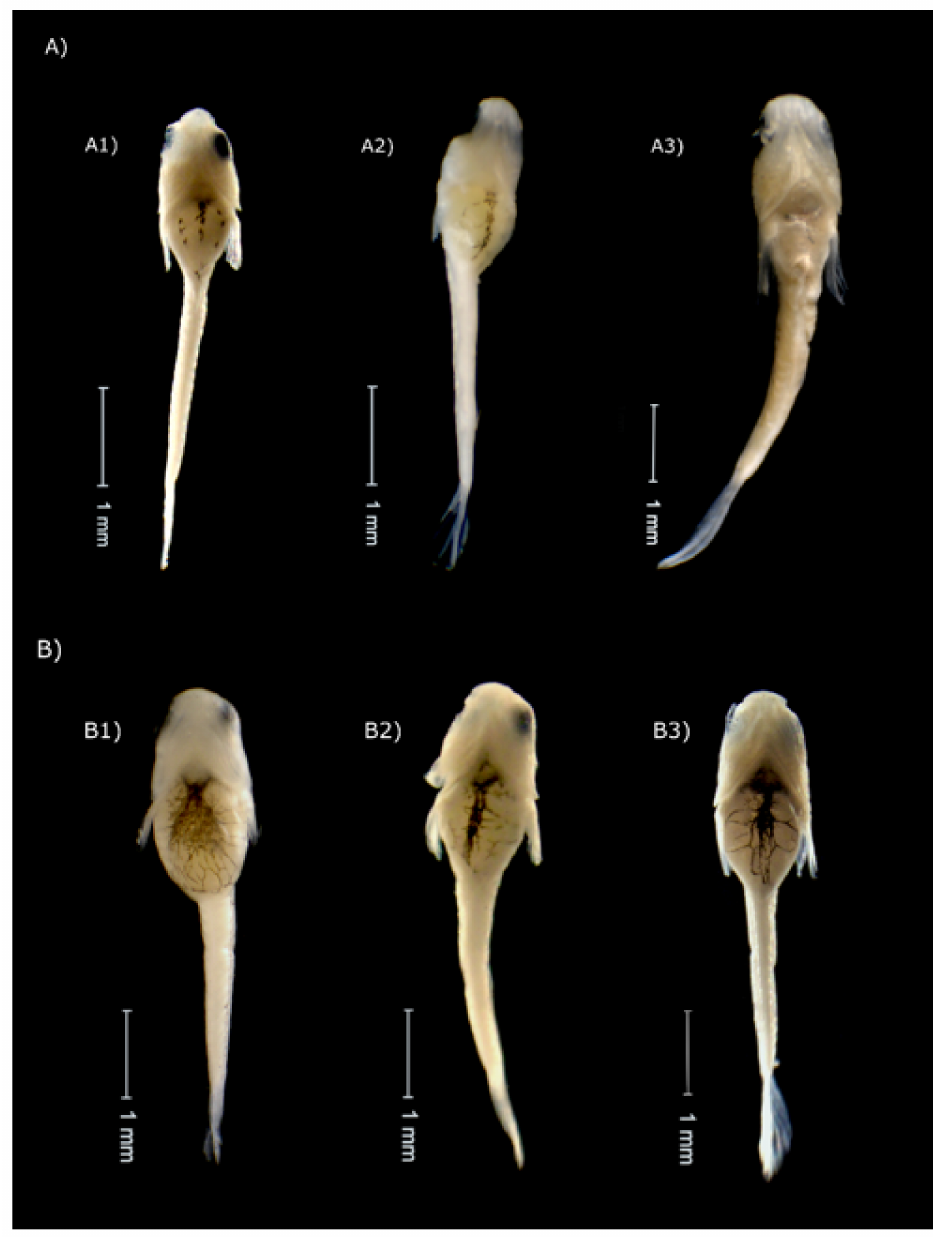
Figure 5. Ventral pigmentation patterns of ( A ) Cyprinodon artifrons, ( A1 ) LT = 4.6 mm; ( A2 ) LT = 4.5 mm; ( A3 ) LT= 6.0 mm; and ( B ) Floridichthys polyommus, ( B1 ) LT = 5.4 mm; ( B2 ) LT = 5.5 mm; ( B3 ) LT = 6.0